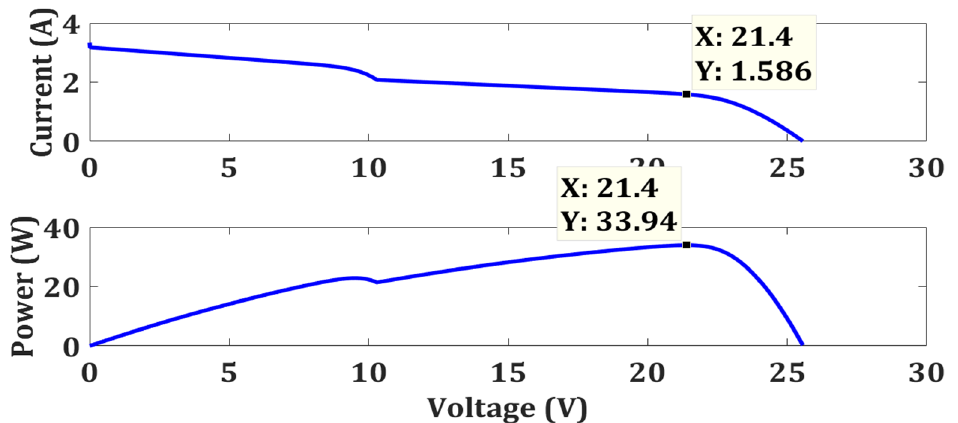
Figure 33. Characteristic curve of 2S PV system for test case 3.